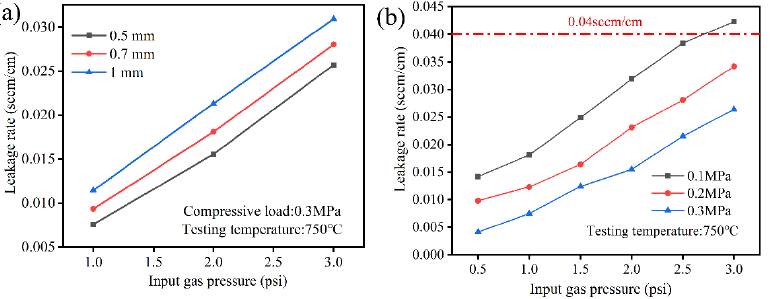
Figure 2. Effect of thickness ( a ) and compressive load ( b ) on leakage rates at 750 °C under input gas pressure of 1 psi to 3 psi.